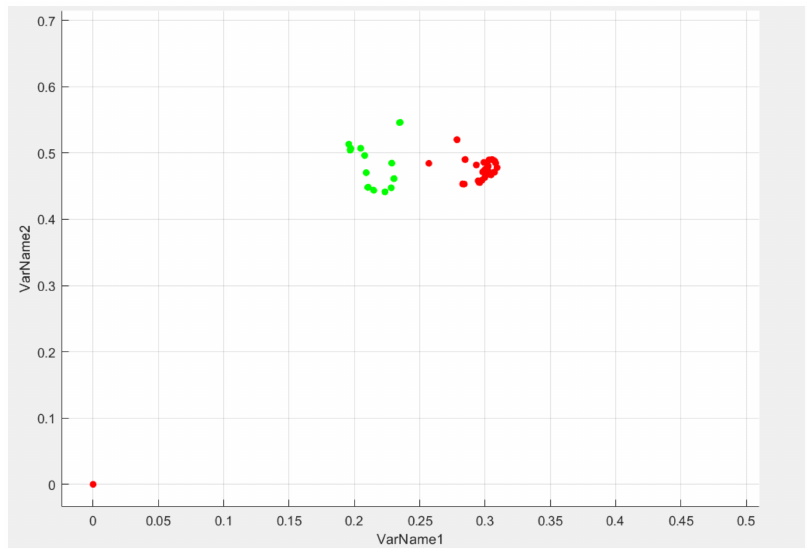
Figure 12. Visualization of gesture data 1.5.